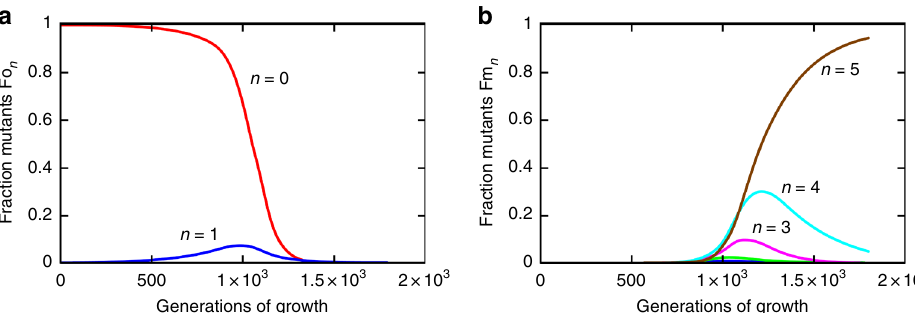
Fig. 5 Population dynamics of different mutant types. Time development of the population fractions for u = 2 × 10 − 6 and v / u = 200. The fractions of the different variants over time in generations are shown on the y -axis, where Fo n and Fm n are the fractions of cells with n selected mutations for non-mutators and mutators, respectively. Non-mutators ( a ) contribute almost exclusively to n = 0 (red curve) and n = 1 (blue curve), while mutators ( b ) dominate totally in the fractions that carry three or more mutations; in the group with n = 2 (green curve), there is some mixing between mutators and non-mutators